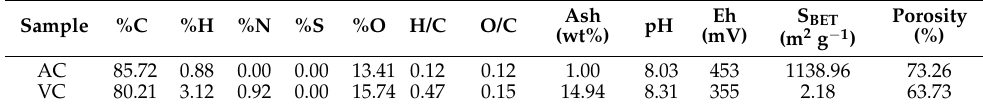
Table 4. Main characteristics of carbon materials.